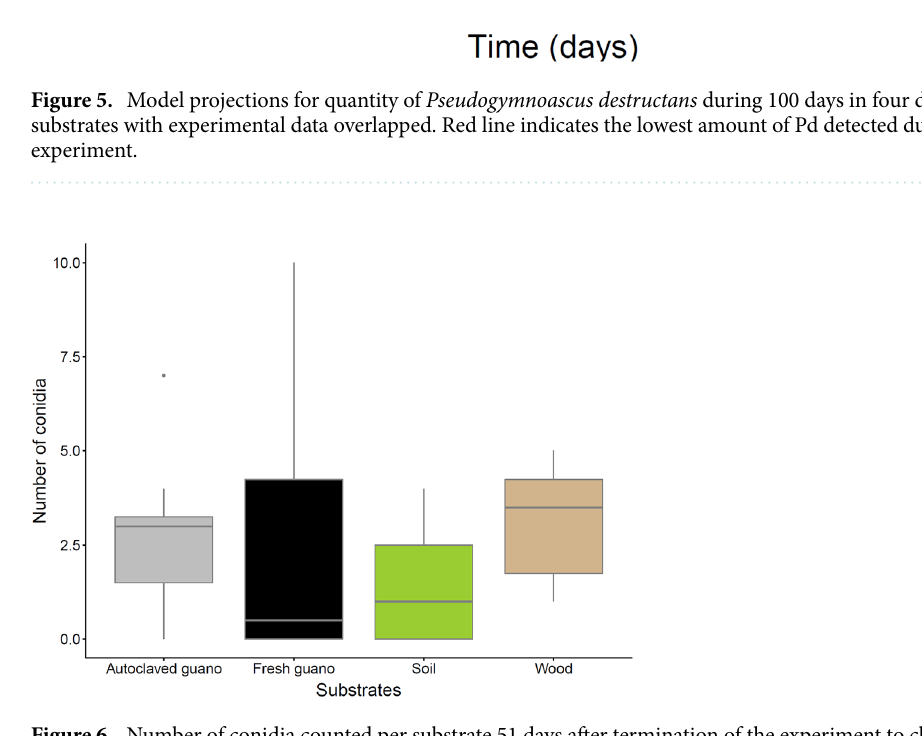
Figure 6. Number of conidia counted per substrate 51 days after termination of the experiment to check viability in SDA cultures (115 days post